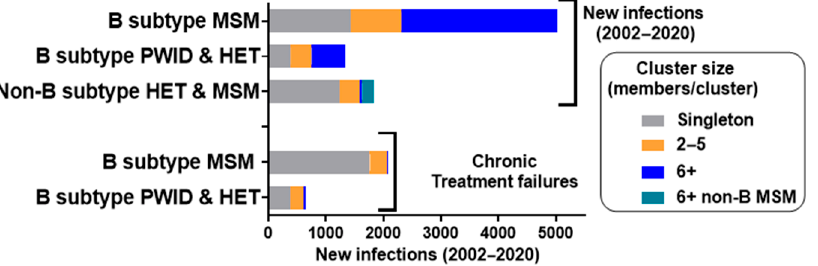
Figure 1. Phylogenetic resolution of the HIV epidemic in Quebec (2002–2020). Neighbour-joining MEGA10 phylogeny inferred singleton transmissions (grey), small-clustered networks with 2–5 members (orange), and large-clustered networks with 6+ members (blue). Newly genotyped, treatment-naïve persons were stratified into predominant MSM (male only) and subtype B PWID/HET (mixed gender) groups. Non-B subtype infections, introduced through migration, included HET and MSM, with 6+ male clusters depicted in green. The chronic treatment failure groups, often infected prior to 2002, did not co-cluster with newly diagnosed, drug-naïve persons (2002-2020).